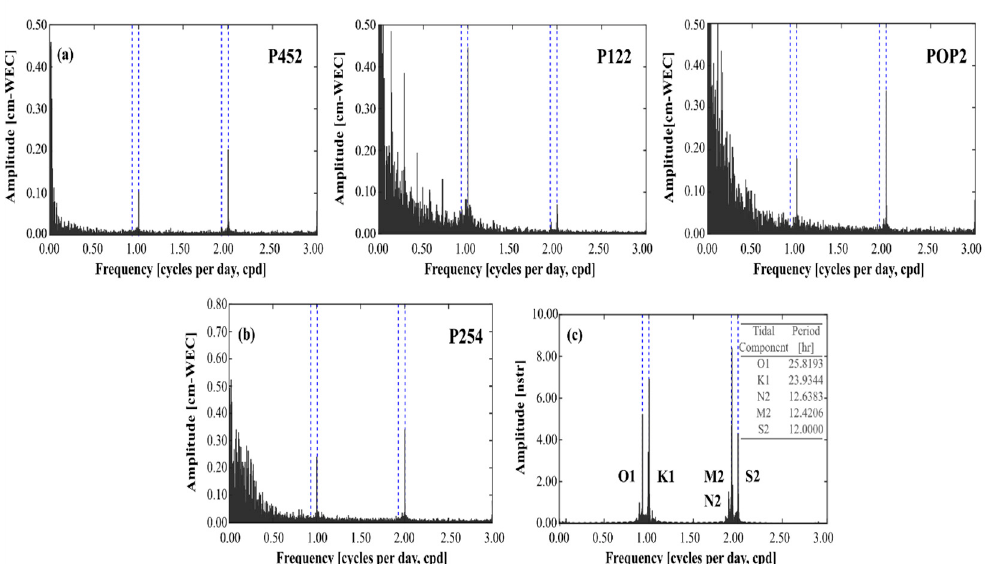
Figure 4. Discrete amplitude spectra for water levels in wells P452, P122, and POP2 ( a ); barometric pressure expressed as centimeters of Water Equivalent Column (cm-WEC) ( b ); and the calculated areal tidal strain ( c ). The dominant Earth tides’ frequencies are indicated in the spectra.